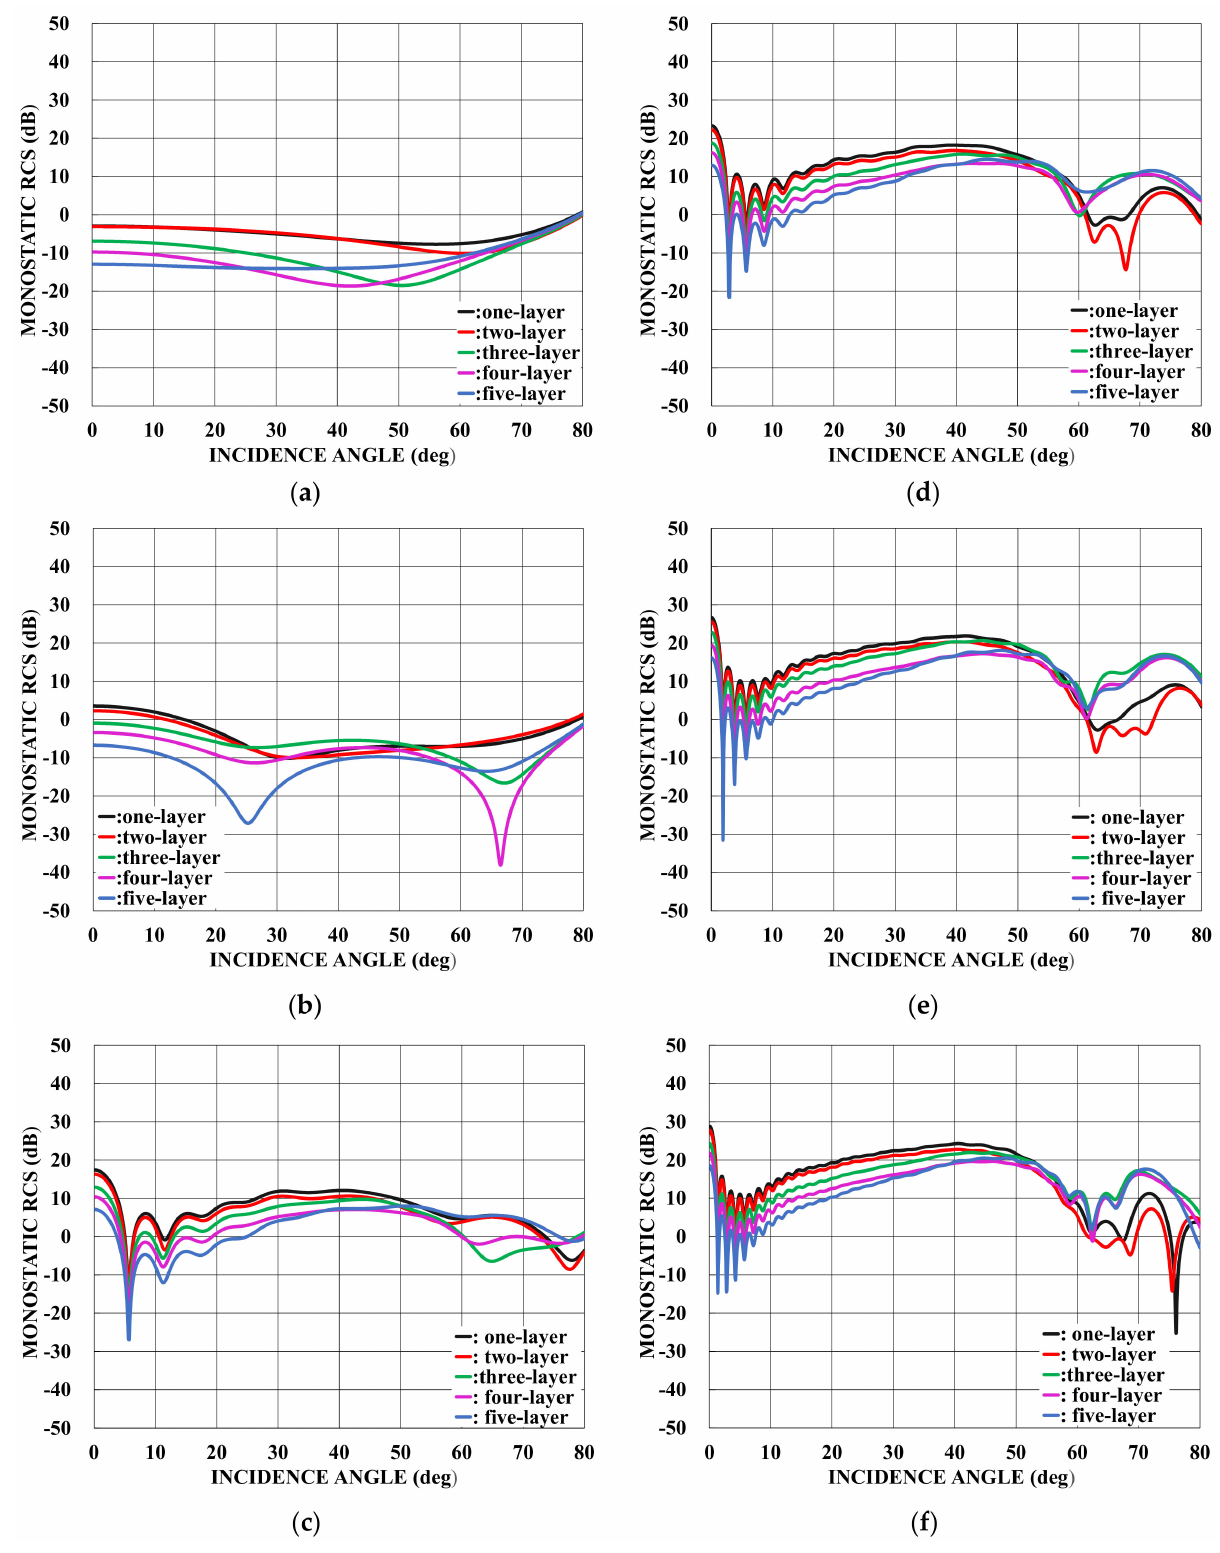
Figure 2. Monostatic RCS [dB] versus incidence angle θ 0 for L 1 /2 b = 0.5, kt = 1.57. : one-layer material loading (regions II − V: vacuum). : two − layer material loading (regions III − V: vacuum). : three − layer material loading (regions IV − V: vacuum). : four − layer material loading (region V: